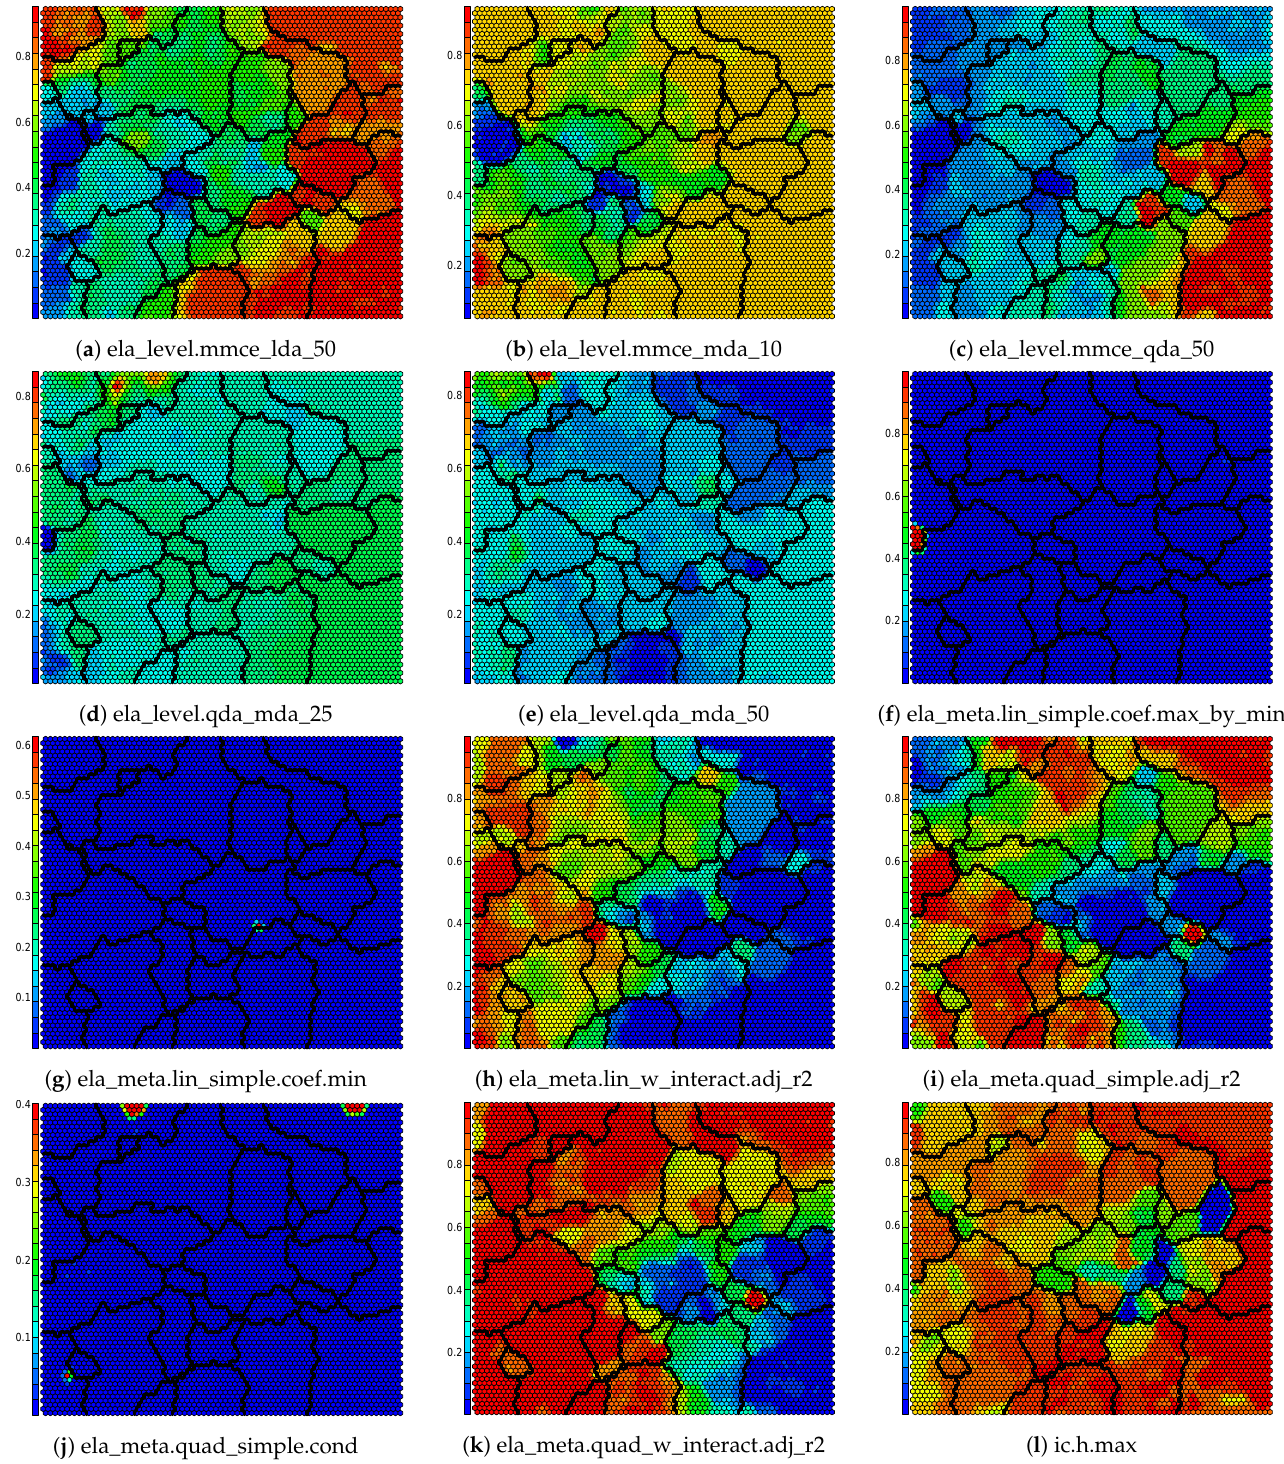
Figure A3. Normalized component maps from the clustered SOM